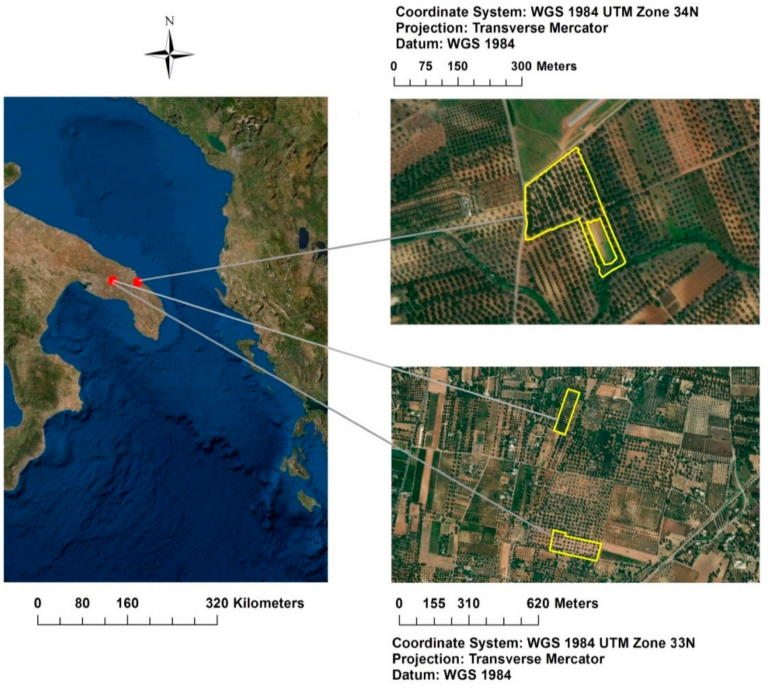
Figure 1. Localization of the three olive groves in the Apulia region (south–eastern Italy): Re field, Fella field, Torchiarolo